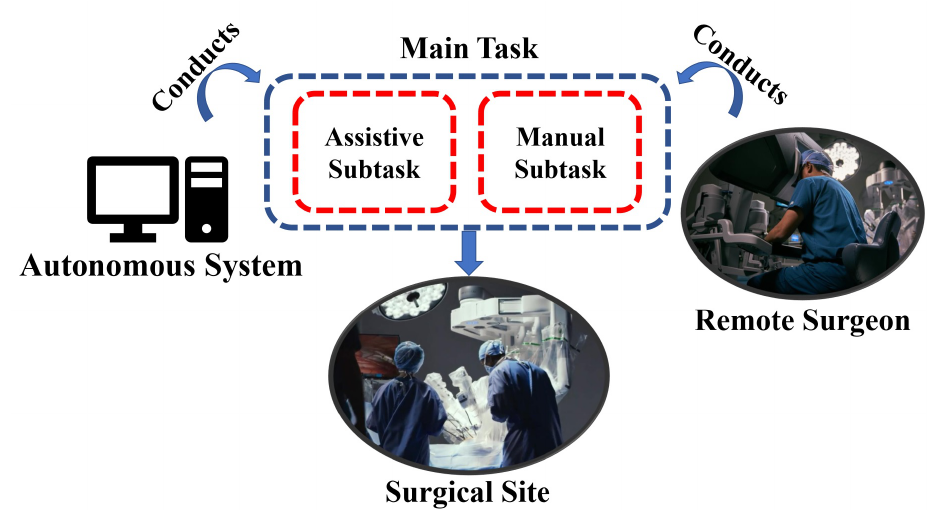
Figure 8. Shared control based on task decomposition, main principle (Images ©2020 Intuitive Surgical,